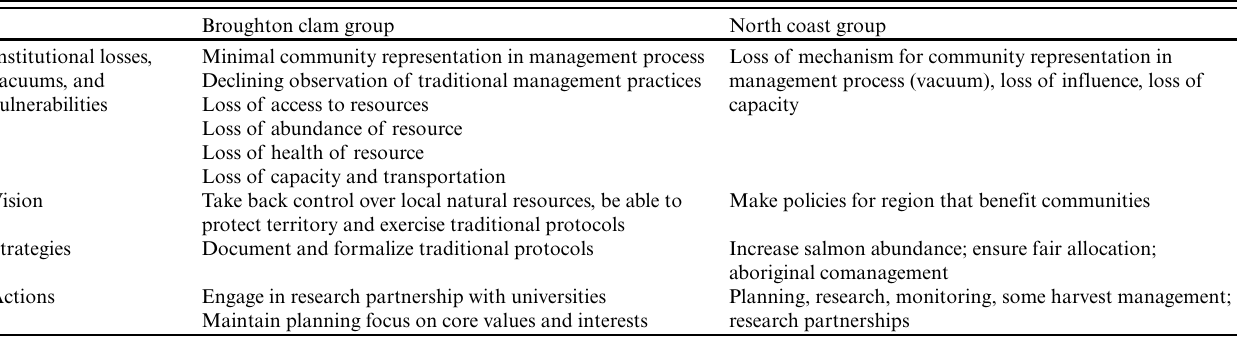
Table 7 . Original institutional loss, visions, strategies, and actions to rebuild